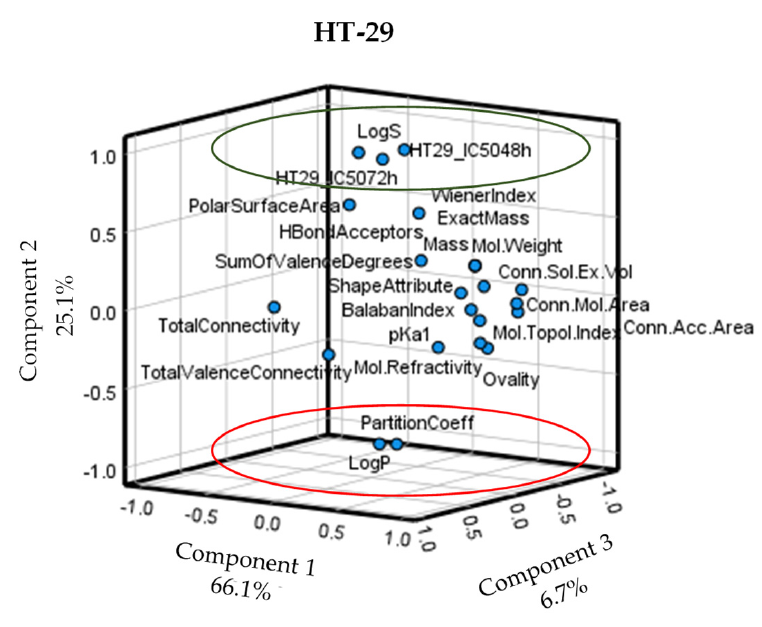
Figure 4. Principal component analysis in a three-dimensional rotated space for HT-29 cells. Red circle, significant inverse variables vs. IC 50 values; green circle, significant direct variables vs. IC 50 values.